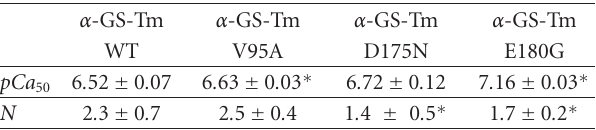
Table 1: Motility speed-pCa regression parameter estimates for regulated thin filaments containing HcTn and WT or mutant